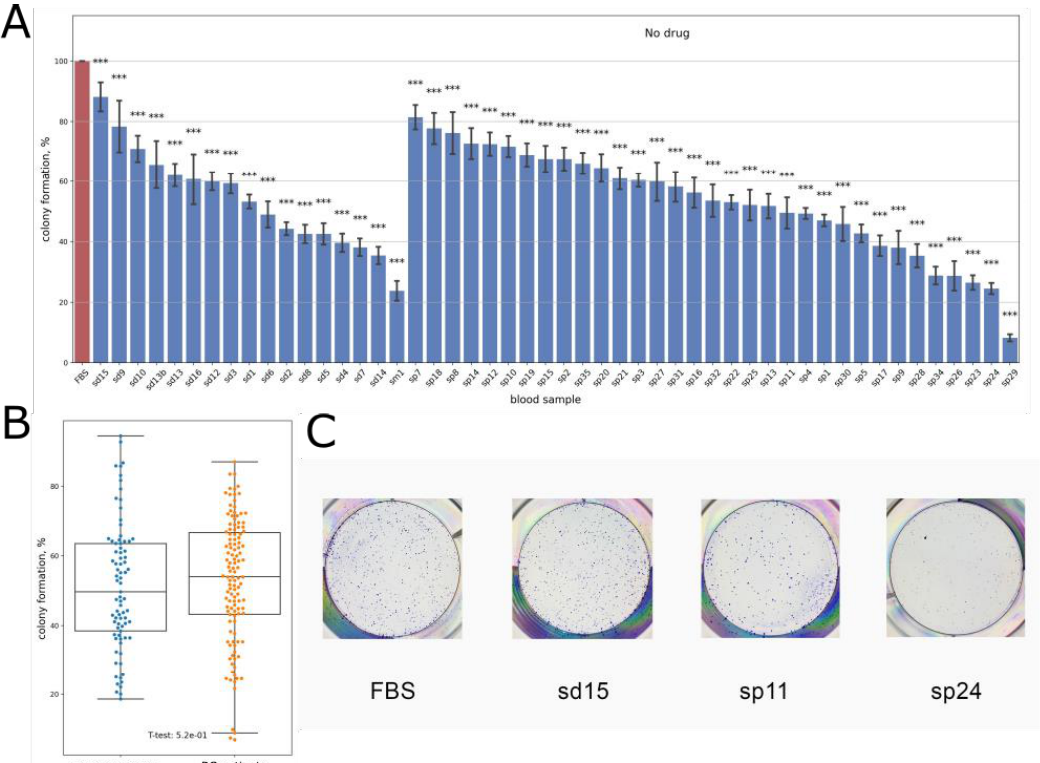
Figure 1. ( A , B ) Colony formation by BT474 in the growth media containing 10% heat-inactivated FBS supplemented with 2.5% human blood serum samples; samples sd correspond to healthy donors; samples sp correspond to HER2+ breast cancer patients. Colony formation is normalized to the growth media containing 12.5% heat-inactivated FBS without drug (column FBS). The data are presented as mean ± standard deviation from three independent replicates (see Table S2). ( C ) Representative photographs of stained clonogenicity assay results used for colony number calculations. *** — p -value < 0.001.